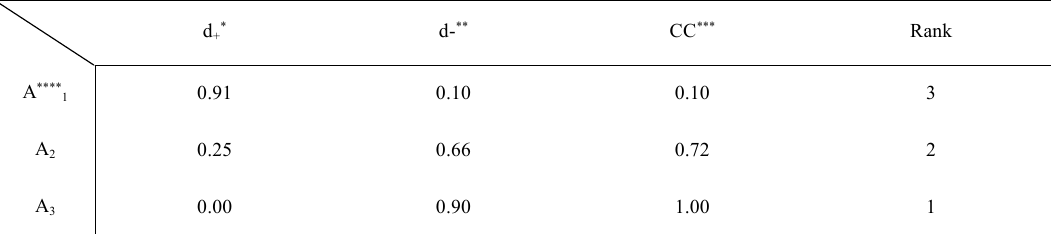
Table 5: Closeness coefficients and